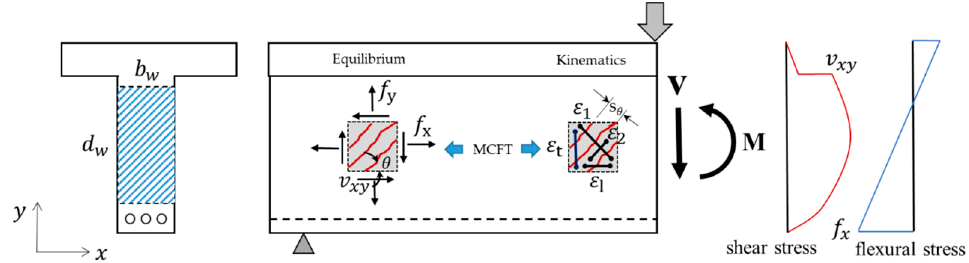
Figure 5. MCFT: Fiber-induced stress at a cracked surface and the associated shear force.